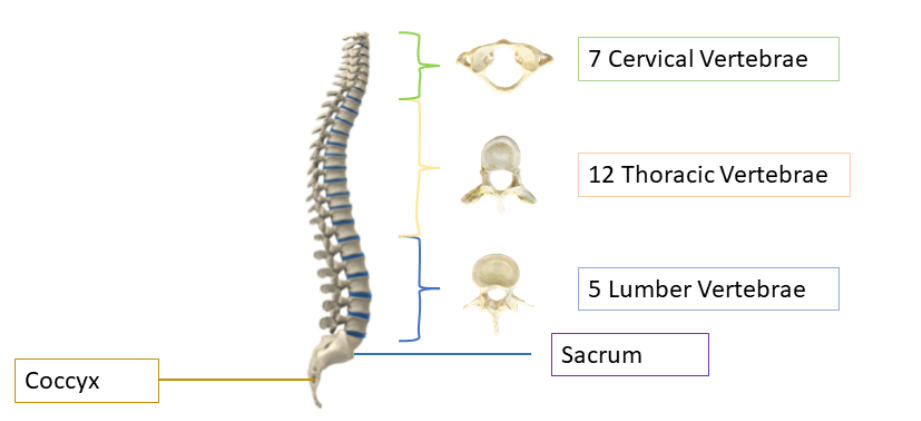
Figure 1. Structure of human spine